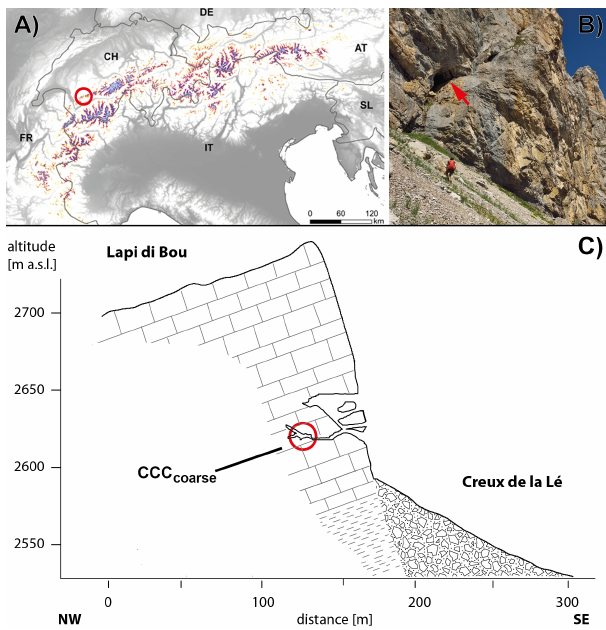
Fig. 1. (A) Site location (circle) plotted on the Alpine Permafrost Index Map (Boeckli et al., 2012); (B) Leclanch´e Cave entrance (ar- row) in the L´e rock cliff; (C) vertical cross section of the Leclanch´e Cave system and location of the coarse crystalline cryogenic cave calcite (CCC coarse )